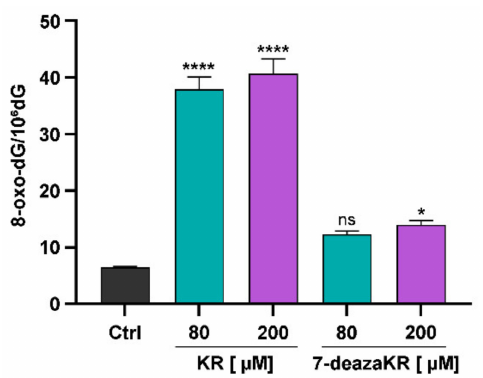
Figure 8. Quantitative analysis of 8-oxo-dG content in T98G cells by HPLC-UV-ED after treatment with KR and 7-deazaKR. The number of 8-oxo-dG residues per 1 × 10 6 base pairs in DNA was calculated in cells after 24 h incubation with KR and 7-deazaKR (80 and 200 µ M). Control cells were cultured in fully supplemented growth medium alone. Statistical significance is indicated with asterisks: (ns) p > 0.05, * p < 0.05, **** p <